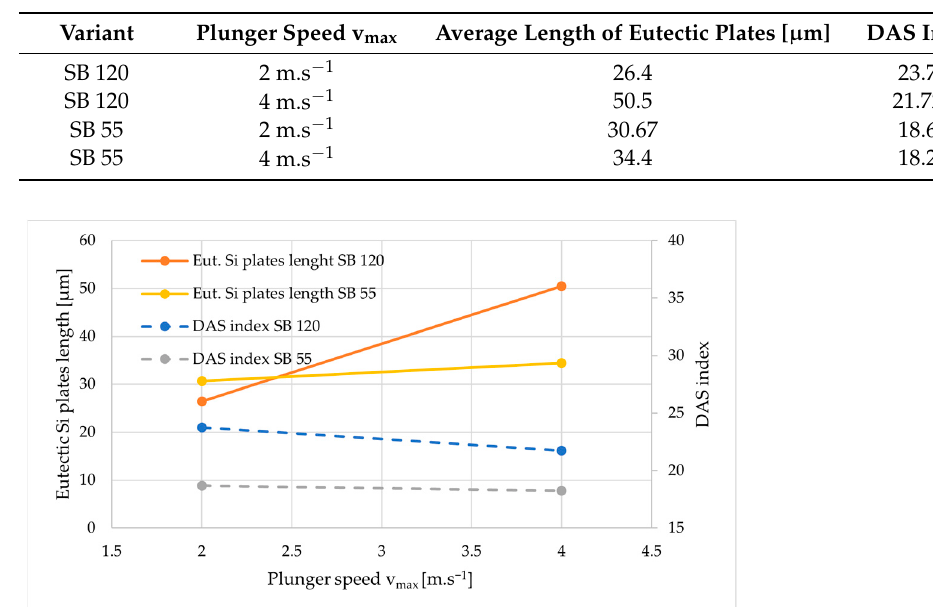
Table 4. DAS index and average lengths of eutectic plates.